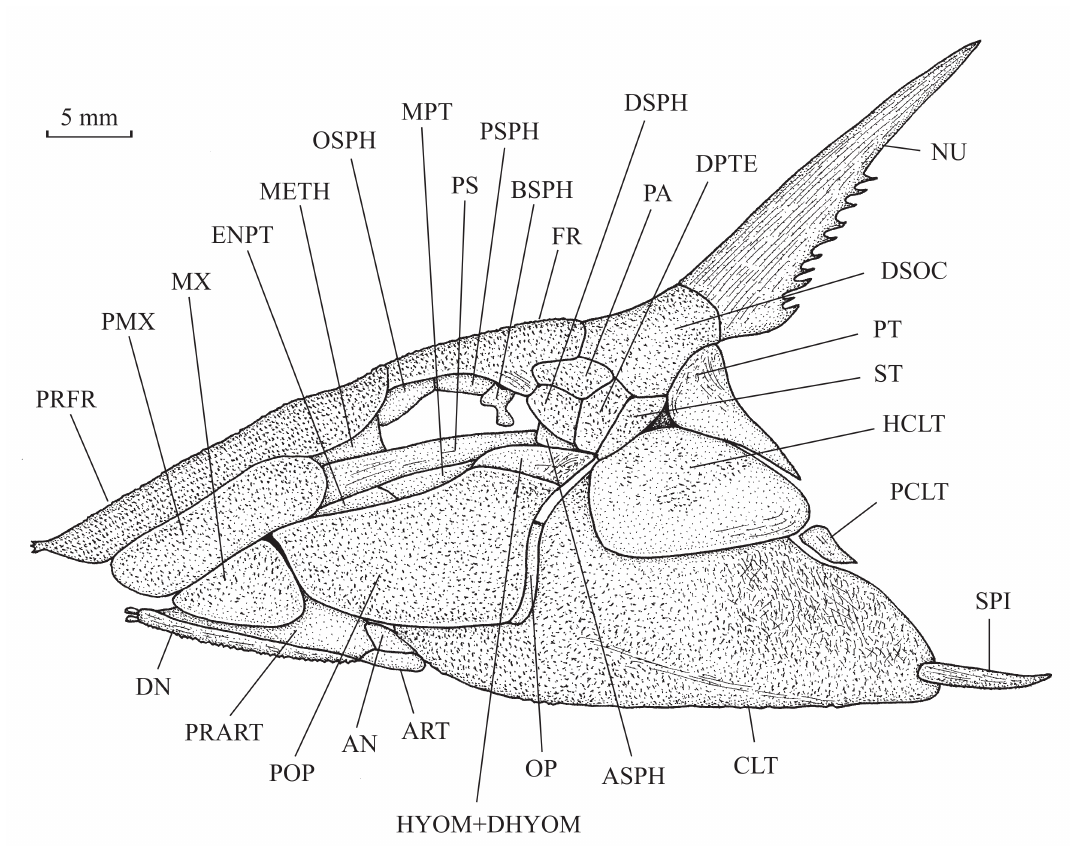
Fig. 6. Joinvillichthys lindstroemi (Davis, 1890). Reconstruction of the skull and the pectoral girdle based on holotype, NRM PZ P. 2073, and samples IRSNB N° P 9276, CLC S-138 and CLC S-324. The scale refers to sample CLC